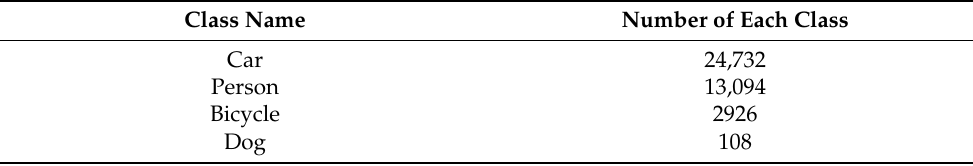
Table 3. The statistics on the number of classes in the aligned FLIR